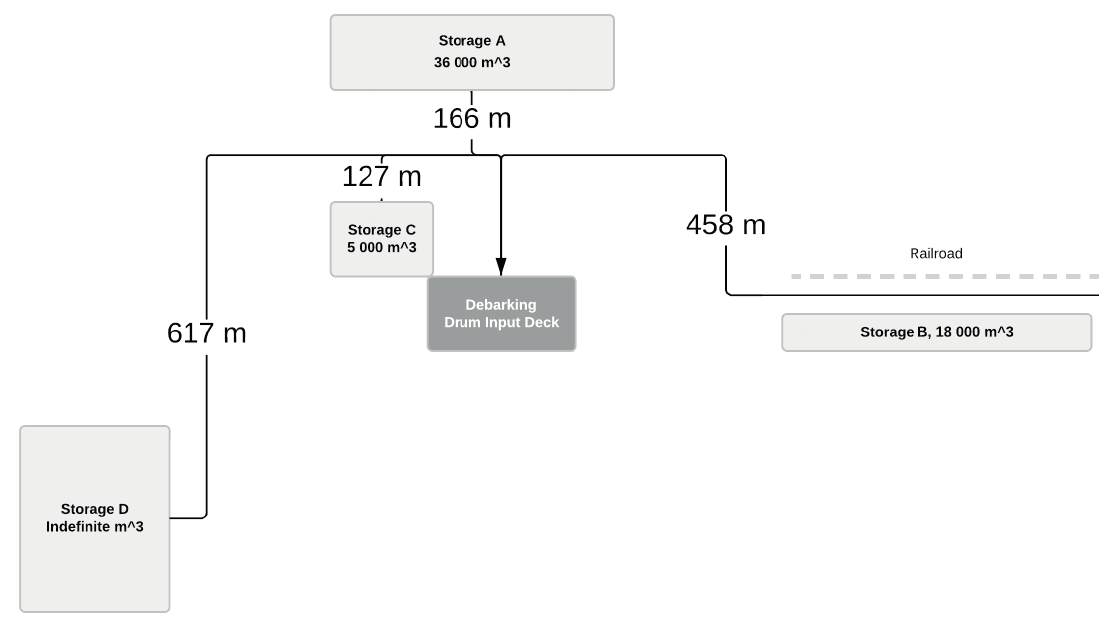
Figure 2. Layout of log-yard’s storage areas with their storage capacities and distances to the input deck for